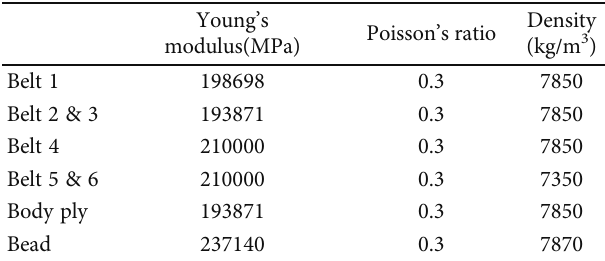
Table 2: Parameters for the mechanical properties of steel wires.